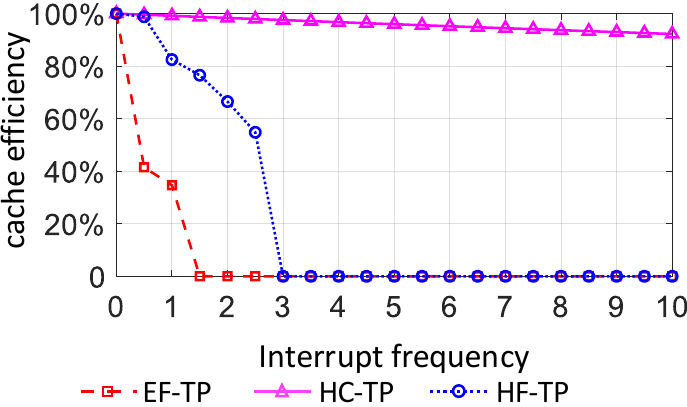
Figure 13. Cache efficiency in continuous